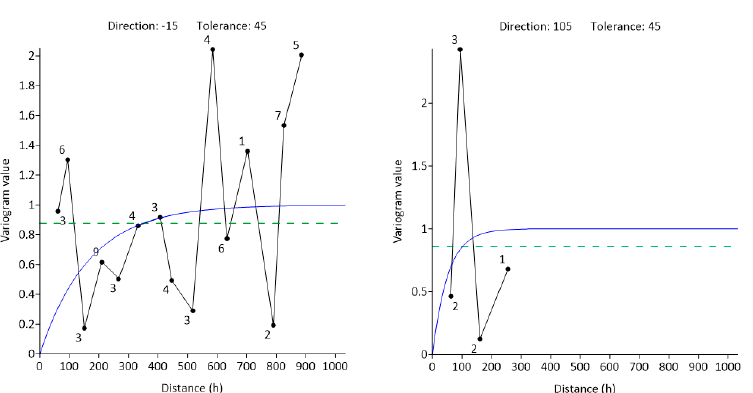
Figure 11 . Variograms for unit (5), northern layer.